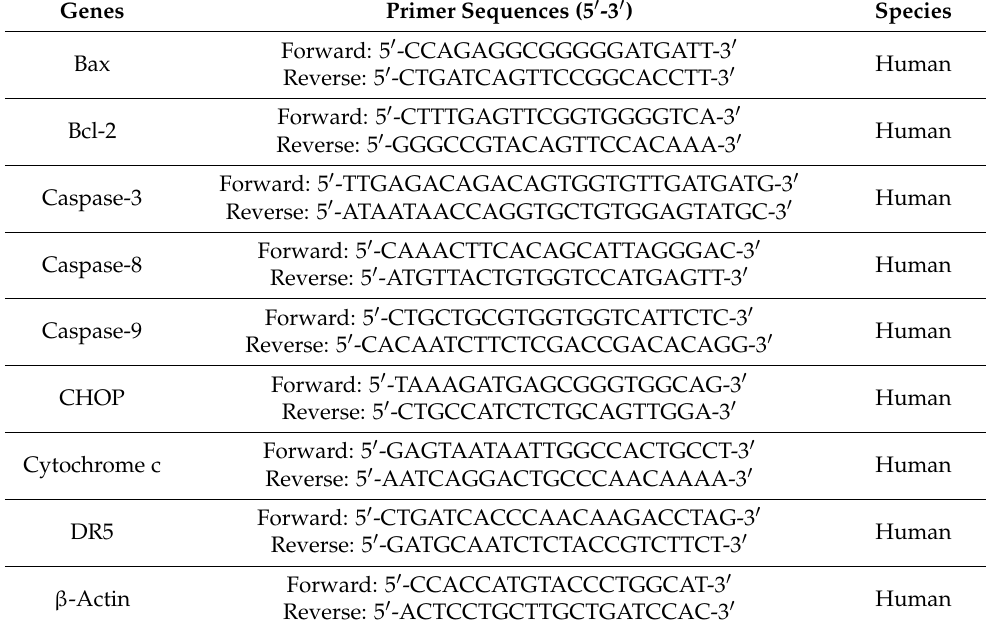
Table 1. Primer sequences used in real-time